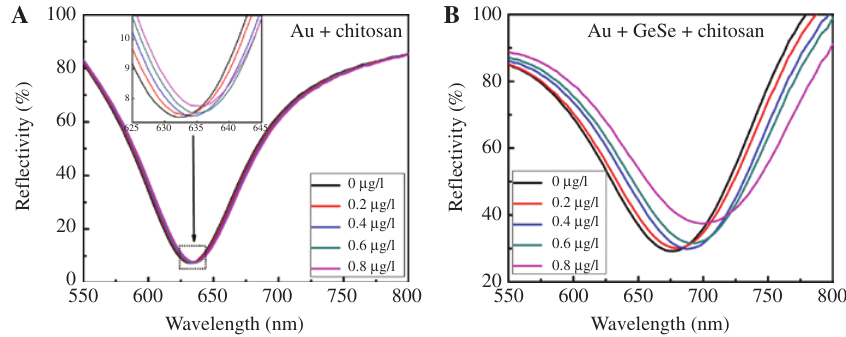
Figure 8: The reflection spectrum of different Pb 2 + concentrations detection. The reflection curves about (A) Au-chitosan and (B) Au-GeSe-chitosan based SPR sensor with wavelength interrogation mode under different Pb 2 + concentrations.